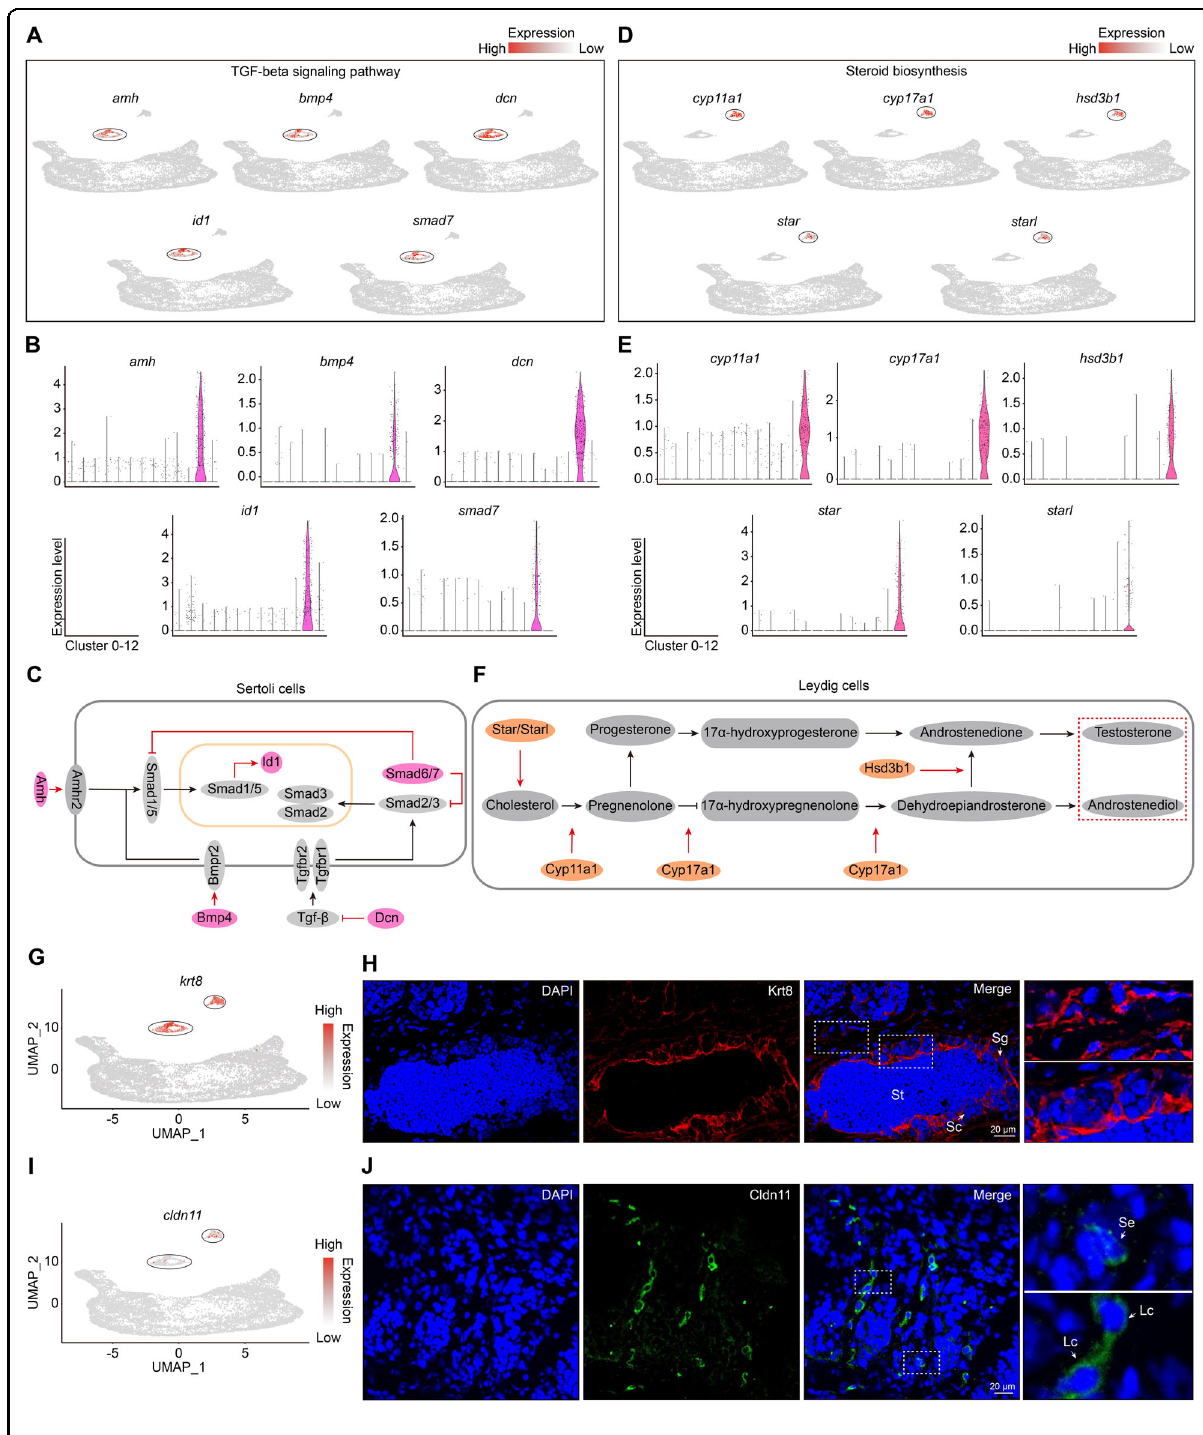
Fig. 4 (See legend on next